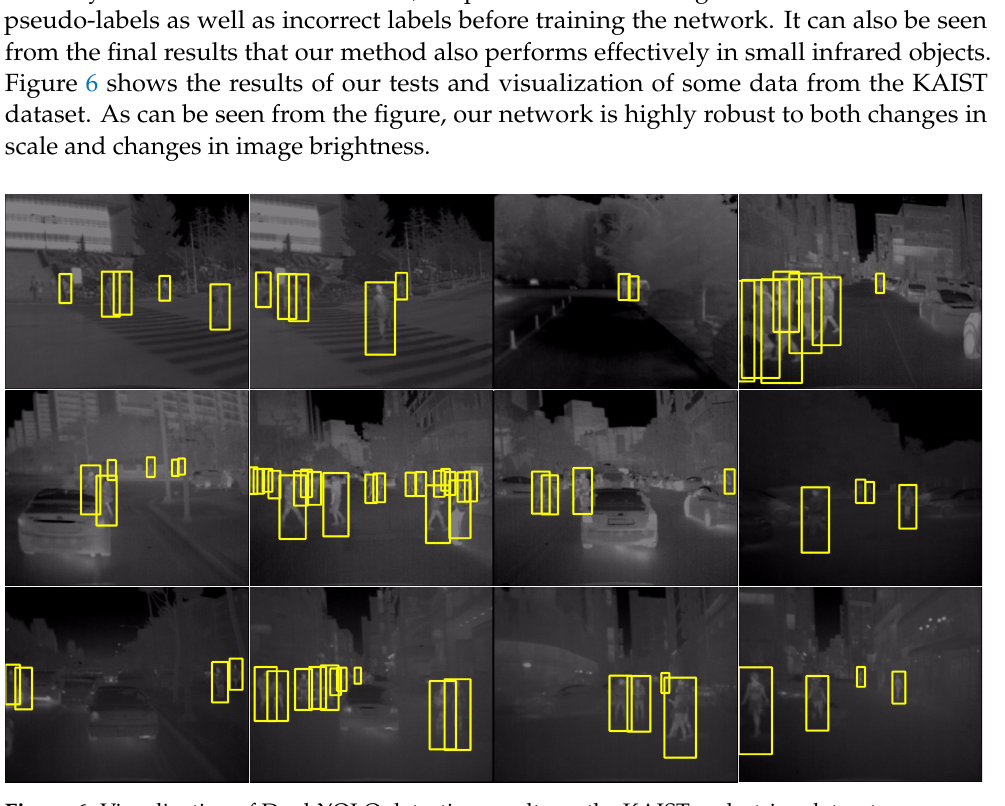
Figure 6. Visualization of Dual-YOLO detection results on the KAIST pedestrian